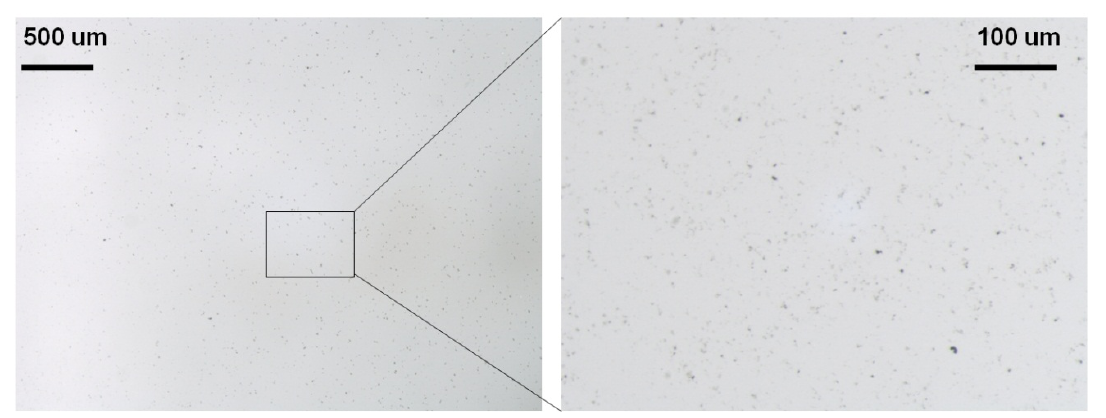
Figure 6. Optical micrographs of CNT dispersion inside a solution which contains chloroform, PDMS and functionalized